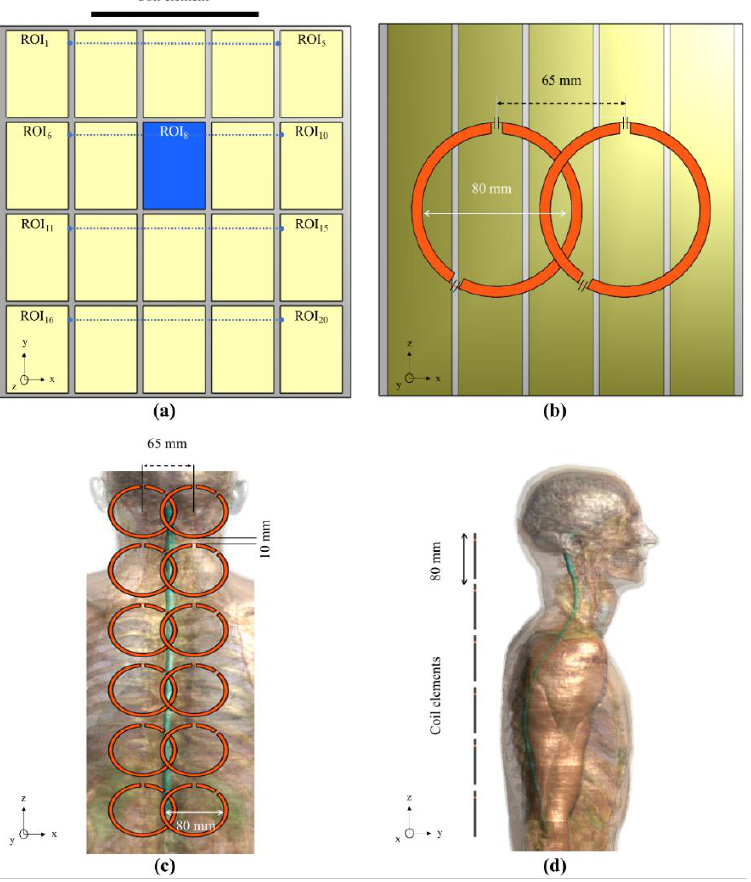
Figure 2. ( a ) Phantom, indicating position of each ROI, ( b ) setup used for coupling analysis between two coils of the same type. Array consisting of 6 pairs of coils for human model, with spinal cord as the target, in ( c ) XZ plane and ( d ) YZ